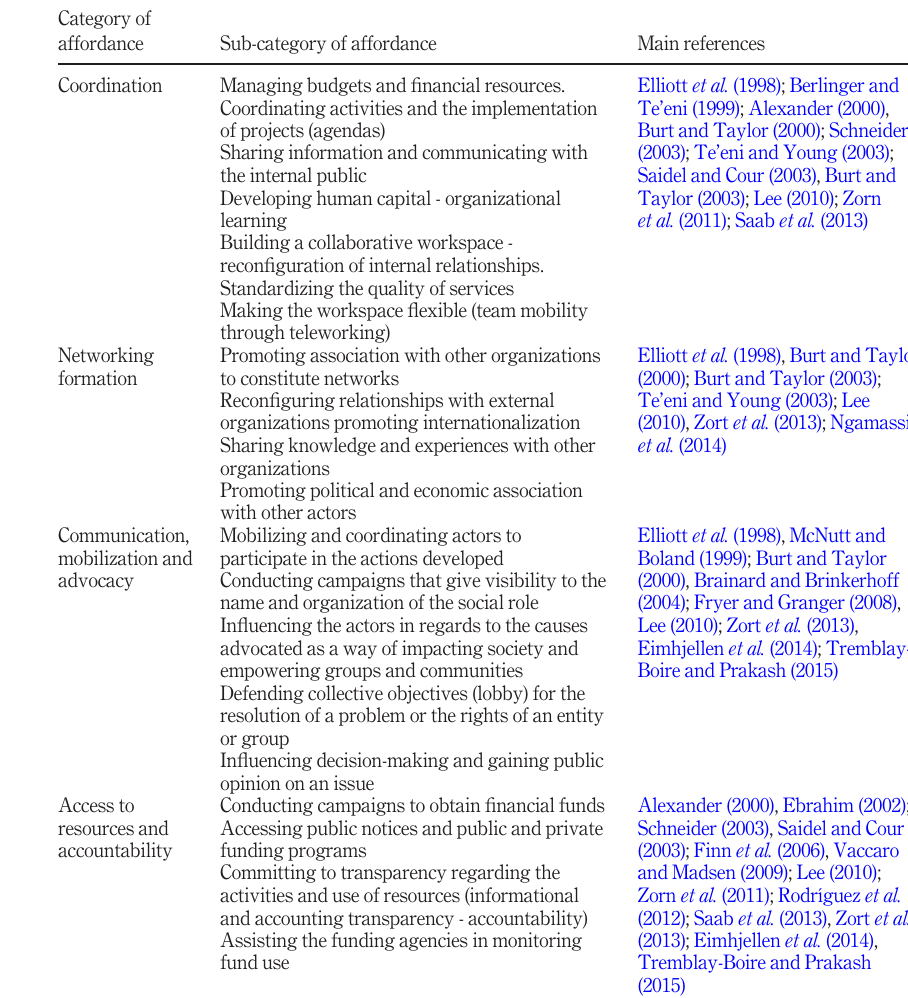
Table II. Categories